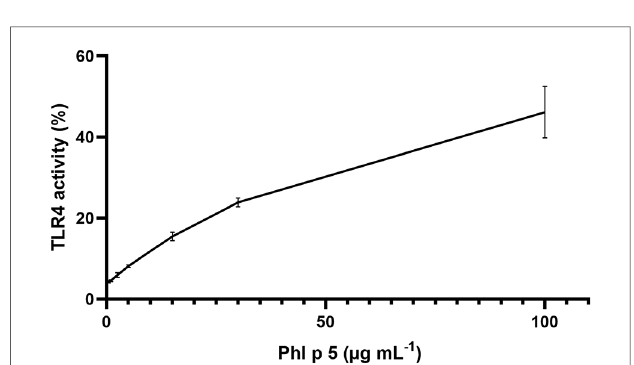
FIGURE 2 TLR4 activation by different concentrations of native Phlp5 determined in HeLa dual-luciferase reporter cells and normalized to LPS. Arithmetic mean values and standard deviations for two independent experiments performed in triplicates. The line is to guide the eye.